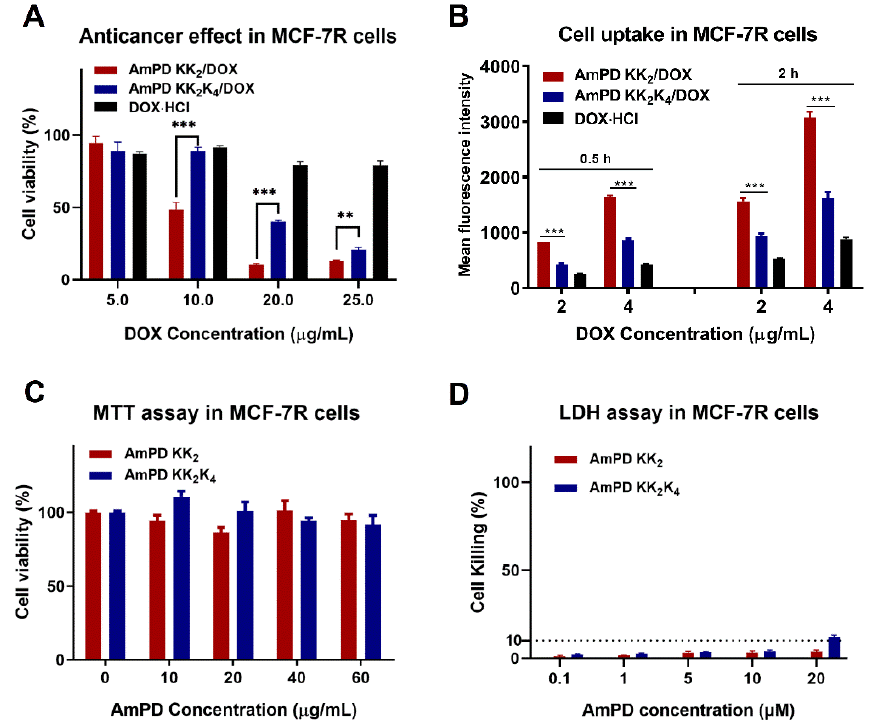
Figure 3. ( A ) The antiproliferative effect of AmPDs/DOX nanoformulations in MCF-7R cells by MTT assay (mean ± SD, n = 3, ** p < 0.01, *** p < 0.001), ( B ) The cellular uptake of AmPDs/DOX nanoformulations in MCF-7R cells by flow cytometry analysis (mean ± SD, n = 3, *** p < 0.001). The toxicity assessment of AmPD-based delivery systems in MCF-7R cells by MTT assay ( C ) and LDH assay ( D ) (mean ± SD, n = 3).